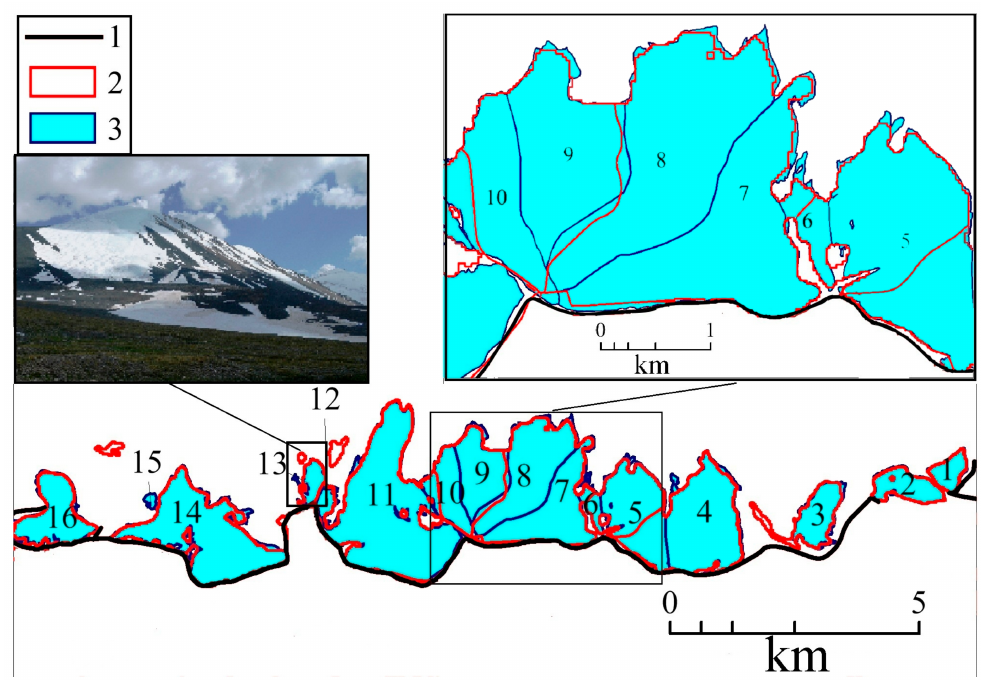
Figure 18. Present glaciers of the northern slope of the Tavan Bogd massif according to our data (2015) and to the RGI 5.0/GLIMS database [41,42]. 1 : Mountain ridges and watersheds; 2 : RGI 5.0/GLIMS contours of the glaciers; 3 : glaciers according to our mapping. Table 7. Areas of the glaciers of the northern slope of the Tavan Bogd massif according to our estimation with the values of the RGI 5.0/GLIMS database [41,42]. Our Data According to RGI 5.0/GLIMS Database [42] ∆